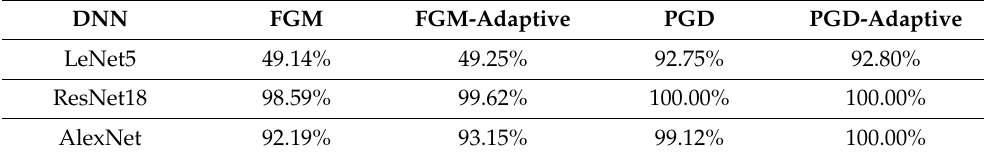
Table 5. Effect of Adaptive